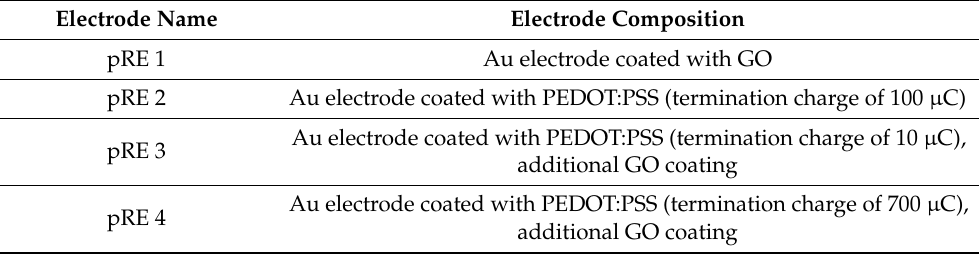
Table 1. Nomenclature of the investigated